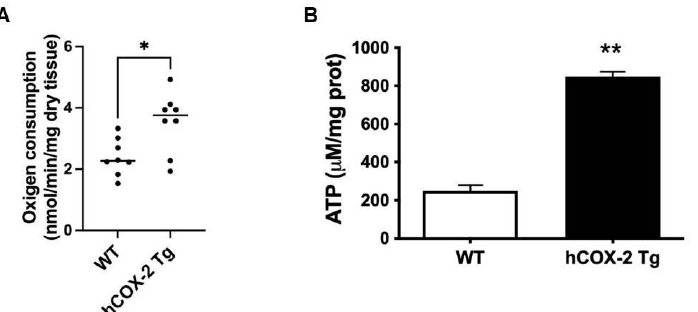
Figure 6. Oxygen consumption and ATP levels are elevated in hCOX-2 Tg mice. ( A ) Oxygen consumption of permeabilized fibers from Wt and hCOX-2 Tg mice was measured as described in Material and Methods. Results are means ± SD; n = 3; * p < 0.05 between animal models. ( B ) ATP levels were determined in a pool of tissue homogenates ( n = 4) from Wt and hCOX-2 Tg mice. ** p < 0.01.